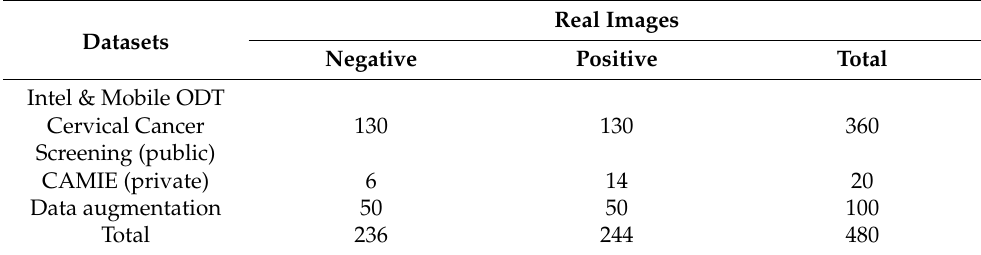
Table 1. Summary of the datasets used in this